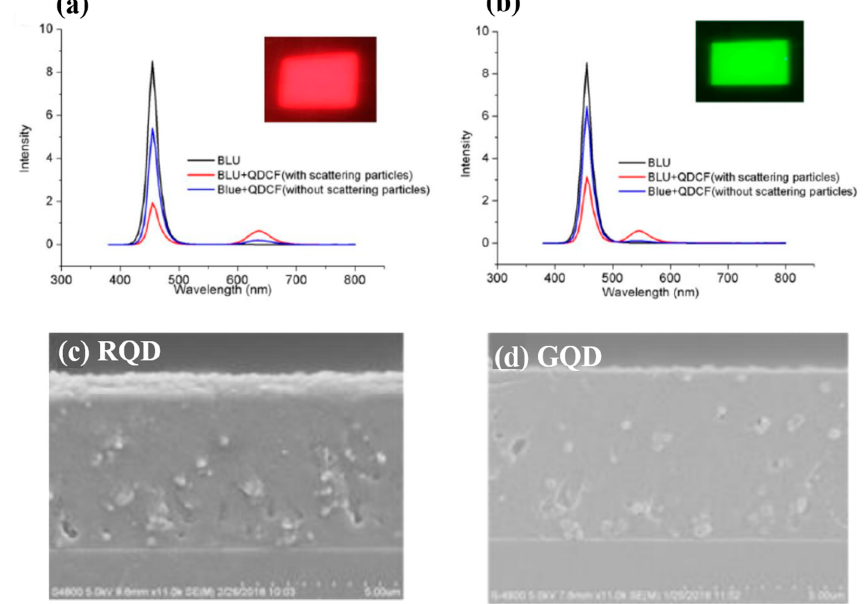
Figure 4. Comparison of ( a ) red and ( b ) green QDCFs spectra with and without scattering particles under blue LED backlight. ( c , d ) The cross-sectional SEM images of red and green QDPR on glass through photolithography process [48]. Figure reproduced with permission from John Wiley and Sons.